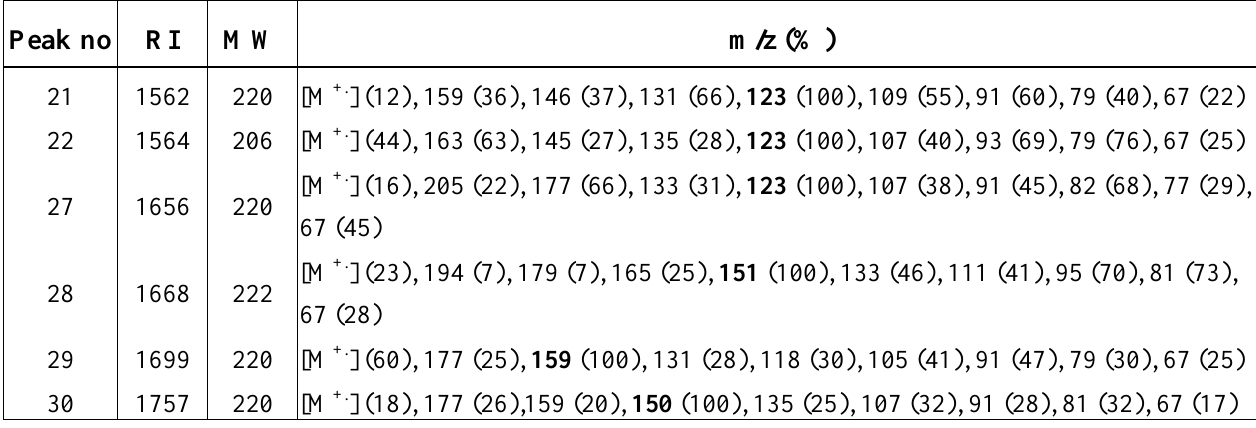
Table 2 . Mass spectral data (m/z (relative intensity)) of known molecular formula